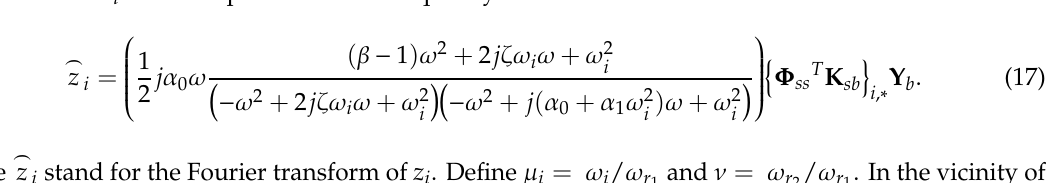
√ ω ω = r 1 r 2 and i